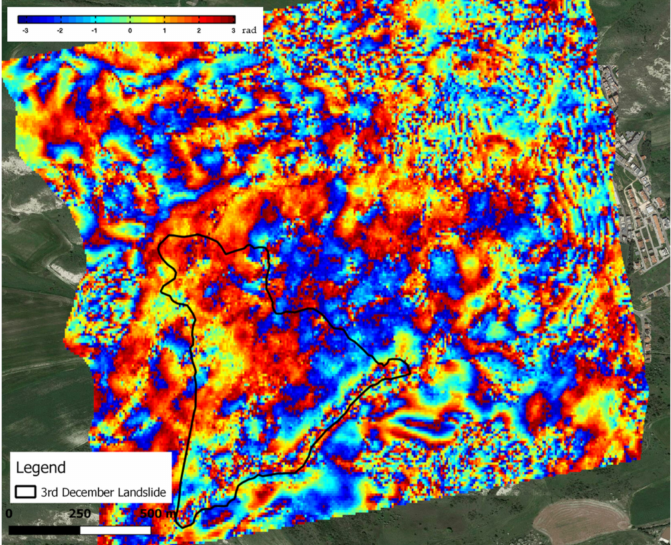
Figure 5. Differential interferogram generated with the images acquired on 2 December 2013 and 3 December